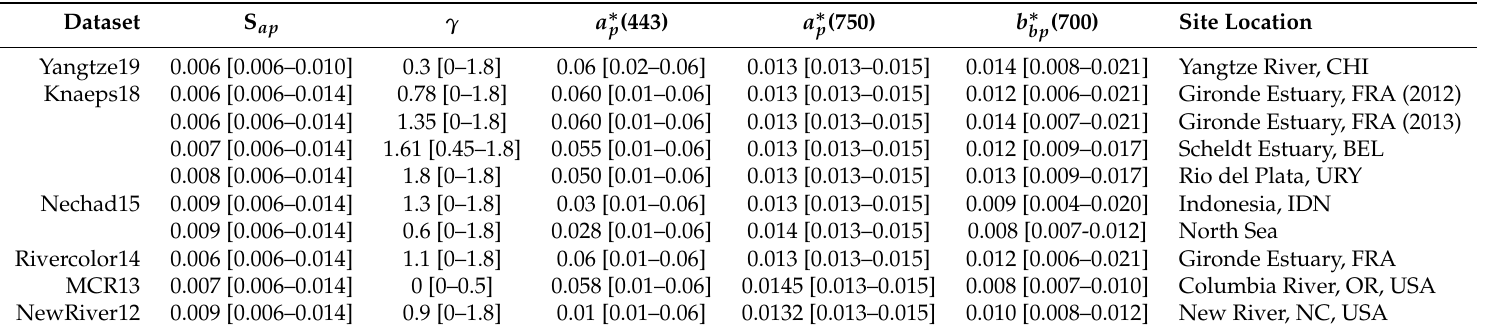
Table 8. Median constrained IOP and ranges by dataset and